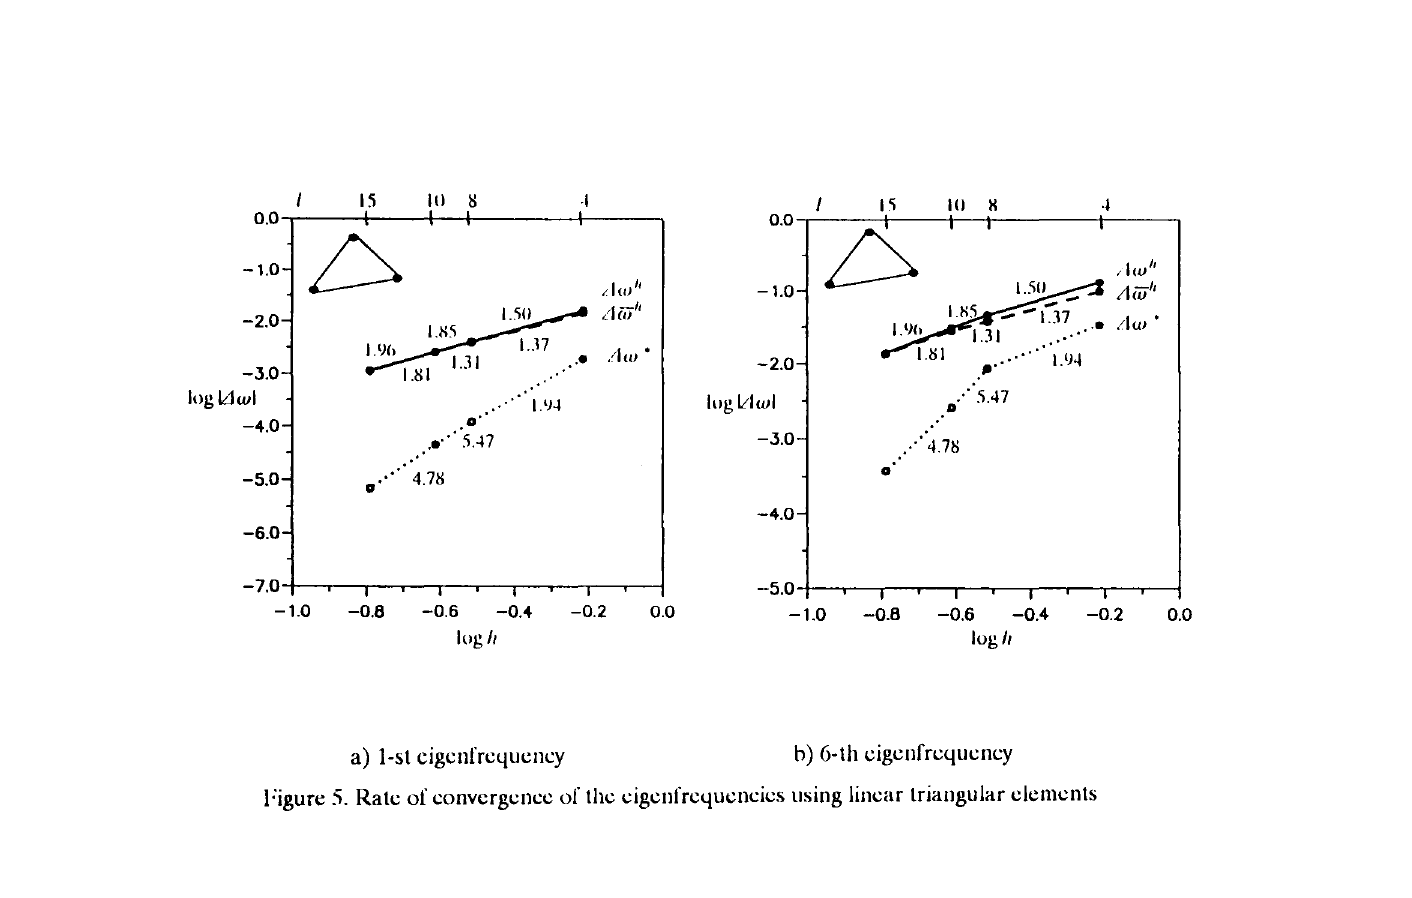
Figure 5. Rate of convergence of the cigcnfrc4ucncics using linear triangular clements